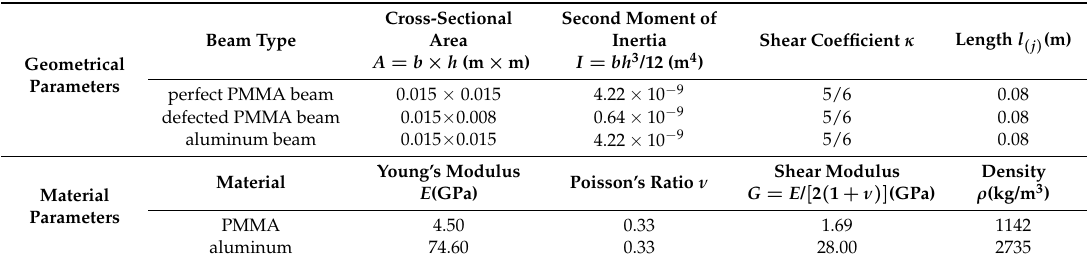
Table 3. The geometrical and material parameters of the constituent beams of the defected phononic crystal beam in Figure